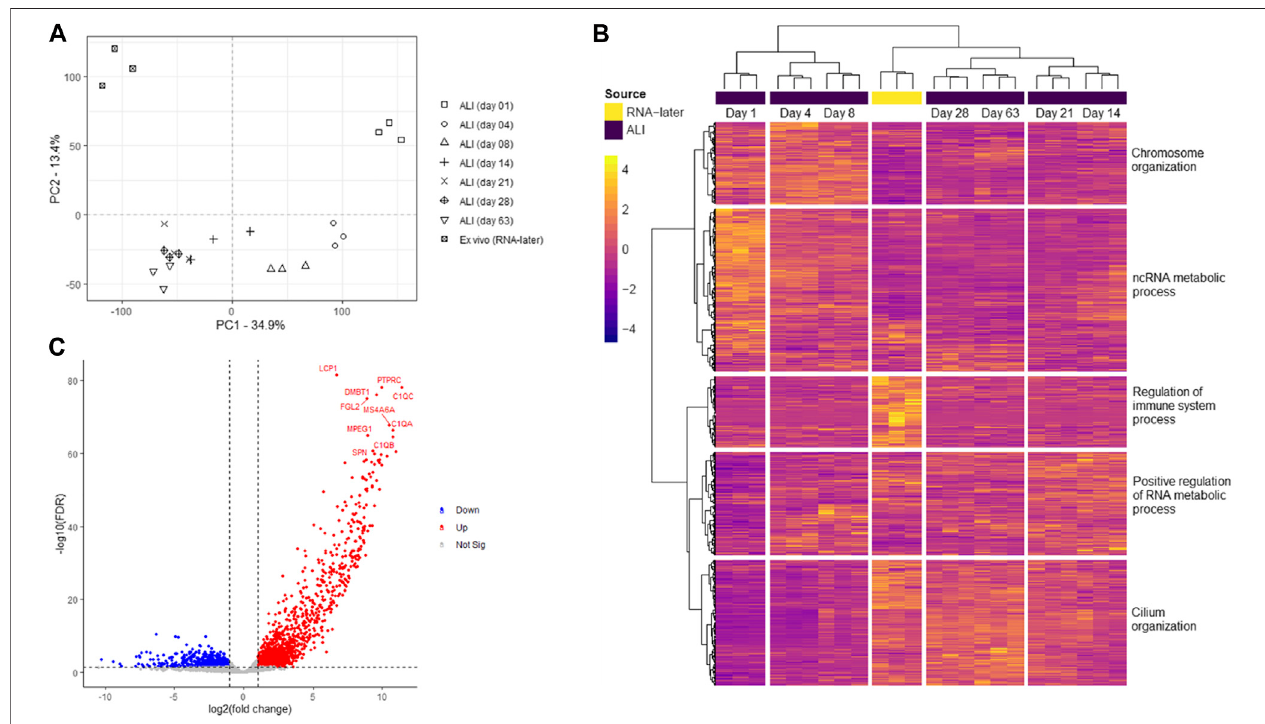
FIGURE 2 | Transcriptome analysis of ex vivo nasal epithelial cells and in vitro ALI-cultures harvested at different time-points during differentiation and ciliogenesis. Ex vivo nasal brushing transcriptomes (RNA-later ® ) were compared to in vitro ALI-culture transcriptomes harvested at days 1, 4, 8, 14, 21, 28, and 63. (A) Principal componentanalysis(PCA)revealedthattheRNA-later ® transcriptomesformadistinctseparateclustercompared totheALI-culturetime-point transcriptomes.TheALI- culture day 1 transcriptome clusters separately tothe other ALI-culture time-points. ALI-culture days 4and 8 display a higher transcriptomesimilarityto each other comparedtotheotherALI-culturetime-points,andthetranscriptomesfromday14onwardsincreaseinsimilarity.Furthermore,theRNA-later ® transcriptomesappearto be most similar to ALI-cultures from day 14 onwards. (B) While heatmap analysis depicts similar transcriptome clustering as PCA further clustering was detected with ALI-culturedays14and21,anddays28and63,clusteringtogether.Fivemajorgeneclusterswithhighertolowerexpressionareshownsegmentedfromtoptobottom: i) 3,023 genes, ii) 6,040 genes, iii) 2,626 genes, iv) 3,832 genes and v) 4,661 genes. The most statistically signi fi cant Gene Ontology biological process terms for each of the major gene clusters were: i) “ chromosome organization ” (FDR p -value 1.29 × 10 – 57 ), ii) “ ncRNA metabolic process ” (FDR p -value 9.96 × 10 – 26 ), iii) “ regulation